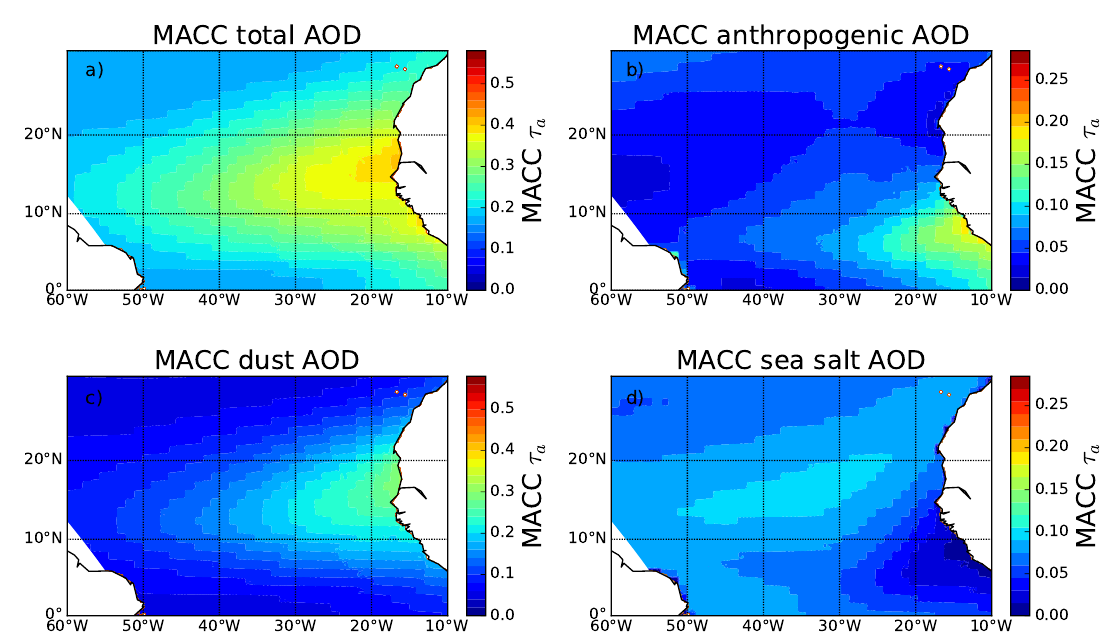
Figure 10. Spatial distribution of ( a ) total AOD total, ( b ) anthropogenic AOD, ( c ) dust AOD and ( d ) sea salt AOD from MACC reanalysis at 550 nm averaged from 2005 to